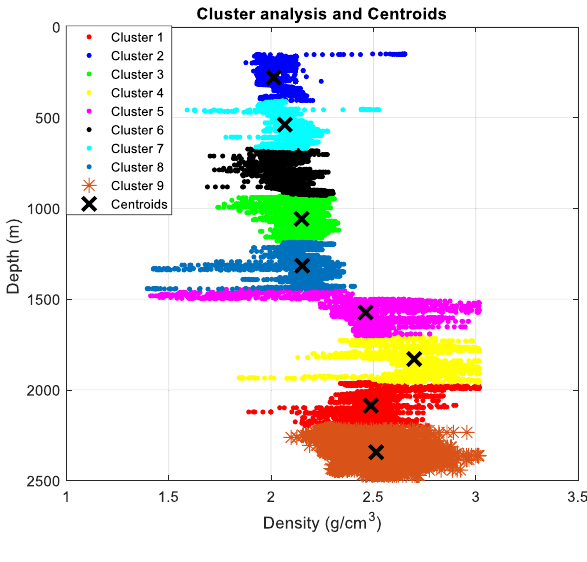
Fig. 2 Well-1 cluster analysis of density